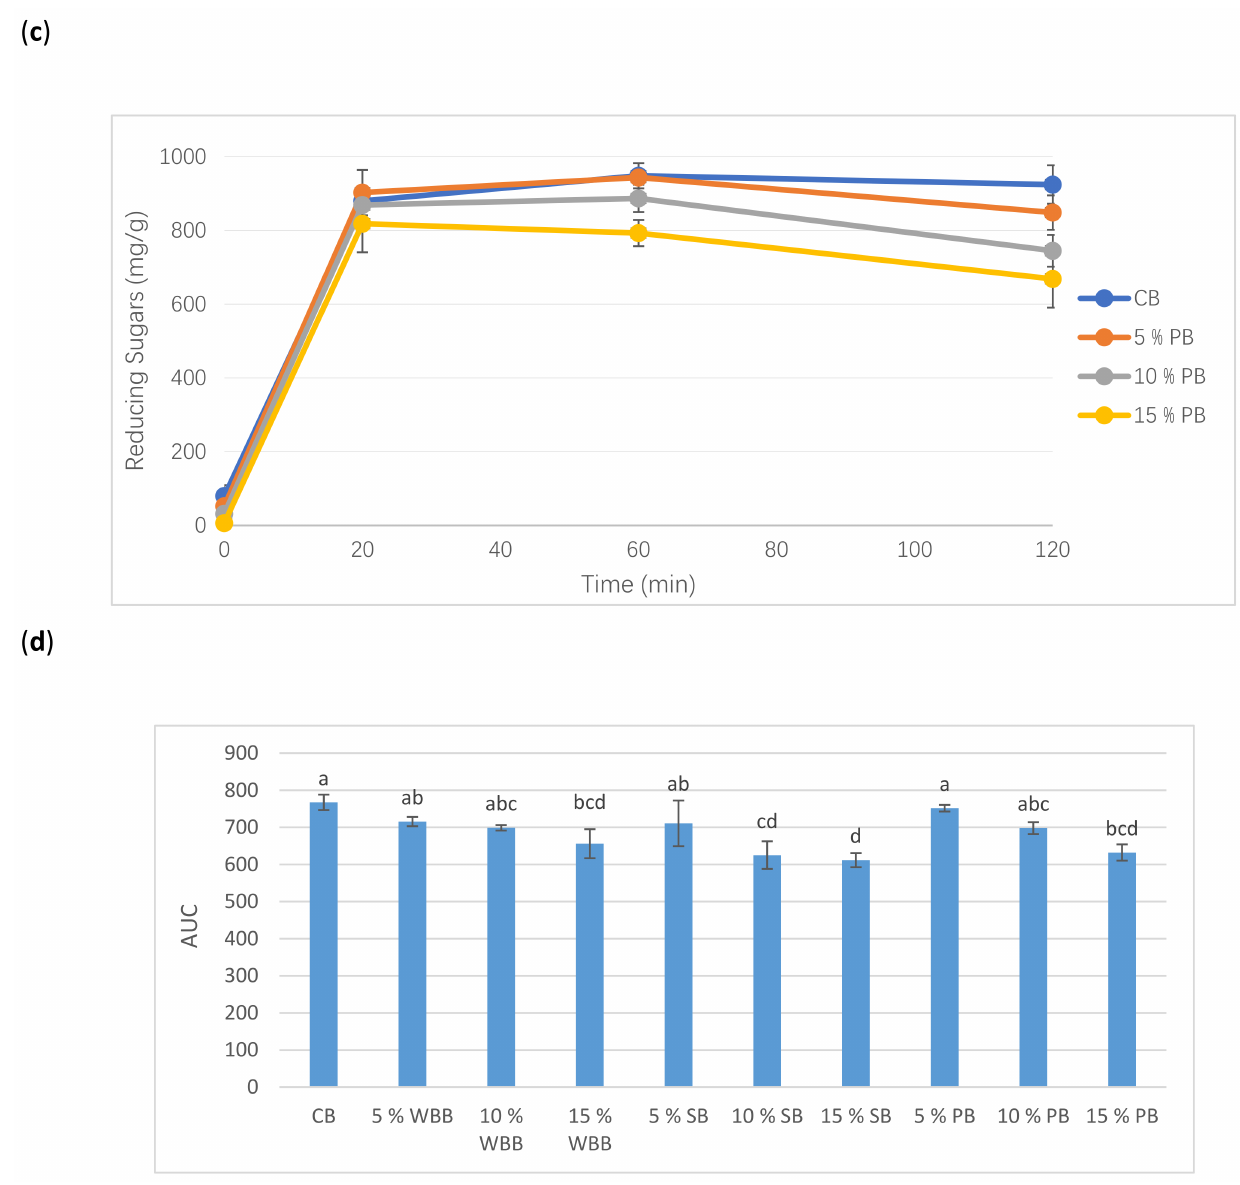
Figure 2. Levels of reducing sugars released during in vitro digestion. Comparing the control to 5%, 10%, 15% white button mushroom bread ( a ); shiitake mushroom bread ( b ); and porcini mushroom bread ( c ). Values for area under the curve (AUC) ( d ): white button mushroom bread (WBB); shiitake mushroom bread (SB) and porcini mushroom bread (PB). Error bars represent standard deviation of replicates. The same letter is not significantly different from each other ( p <